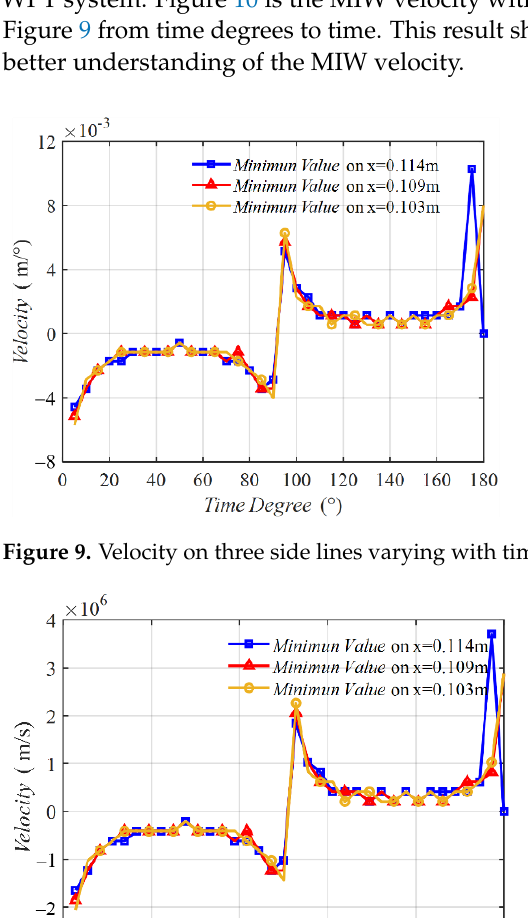
( , , ) H x z t on three side lines varying with time x